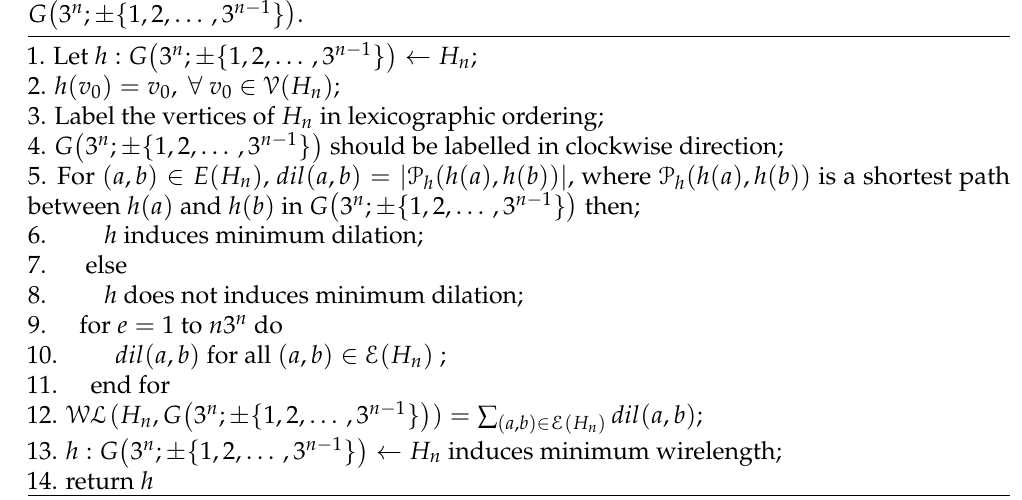
Algorithm 2 Embedding of 3-Ary n -Cube, H n , into the circulant